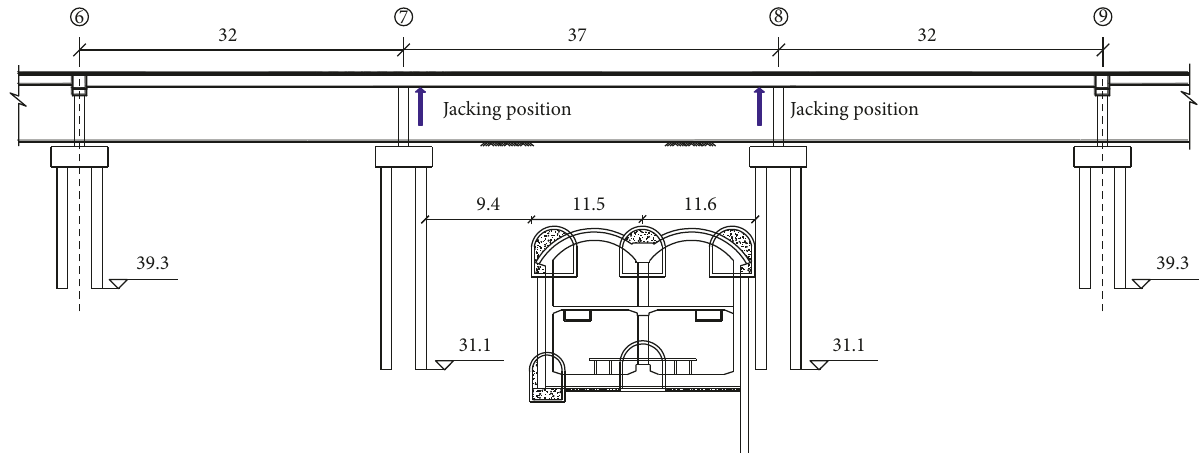
Figure 10: Jacking position schematic diagram (unit: m).